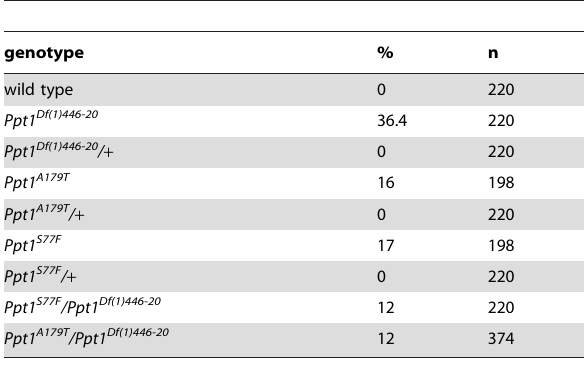
Table 1. Percentage of hemisegments in Ppt1 -deficient embryos with missing EVE + RP2 neurons.